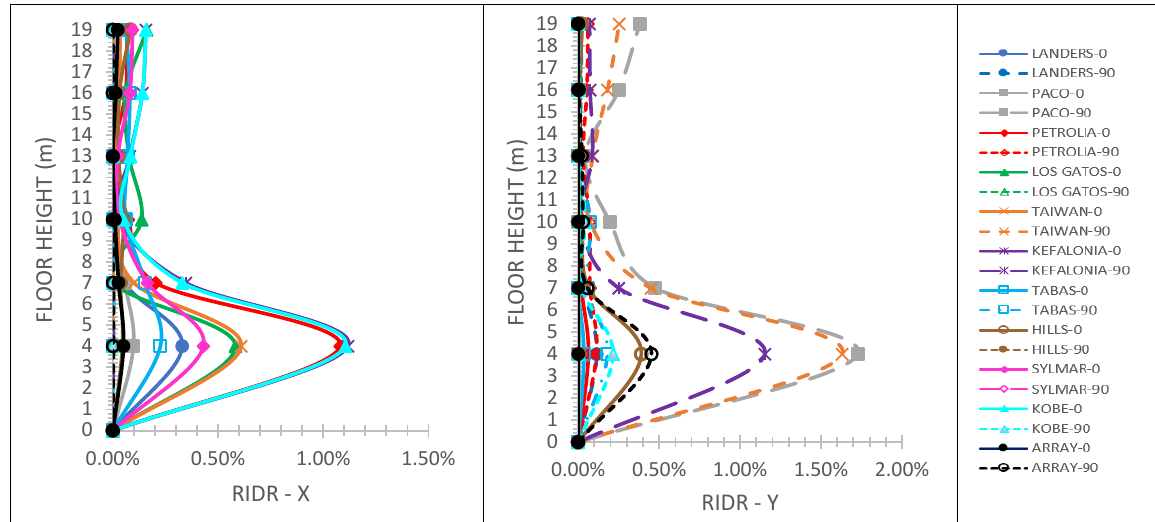
Figure 19. RIDR along X ( left ) and Y ( right ) horizontal directions of the six-story mixed building, considering the fixed connection of the steel structure to the r/c one.